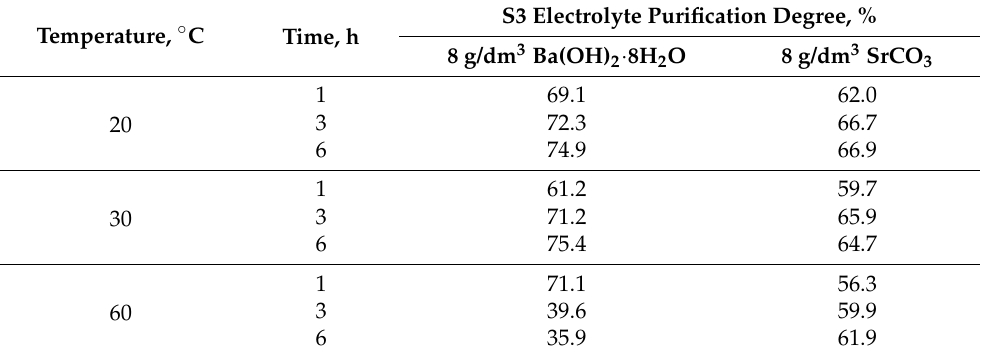
Table 4. Electrolyte purification degree with 8 g/dm 3 addition of barium hydroxide octahydrate and strontium carbonate.